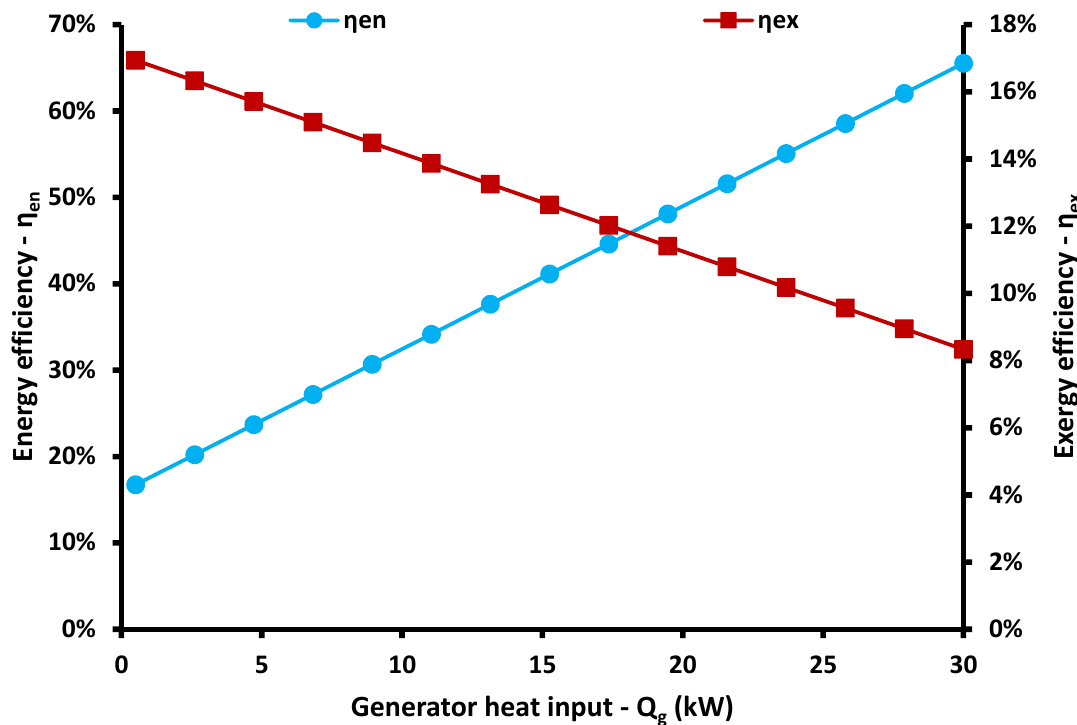
Figure 12. Energy and exergy efficiency for different generator heat input values.